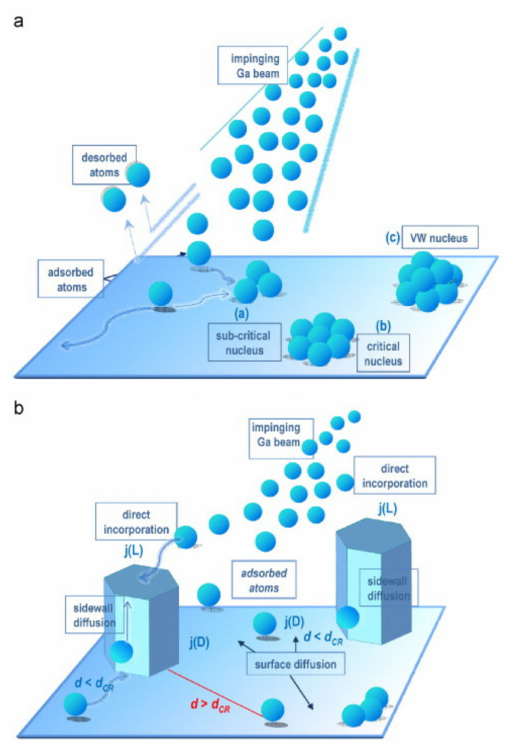
Figure 9. The schematic of ( a ) the nucleation process of nanowires in Volmer–Weber (VW) growth mode. ( b ) Nanowire growth from stable nuclei. Reproduced from [112], with permission from Copyright Elsevier,